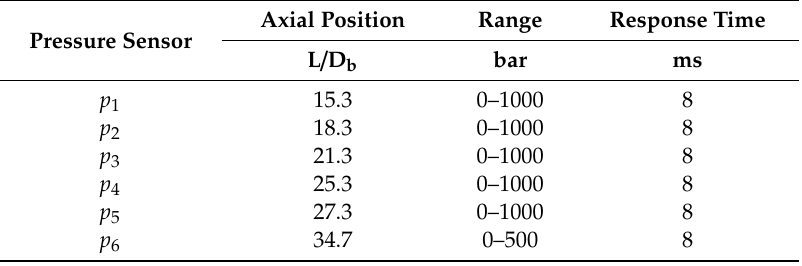
Table 5. Positions, measuring ranges, and response times of pressure